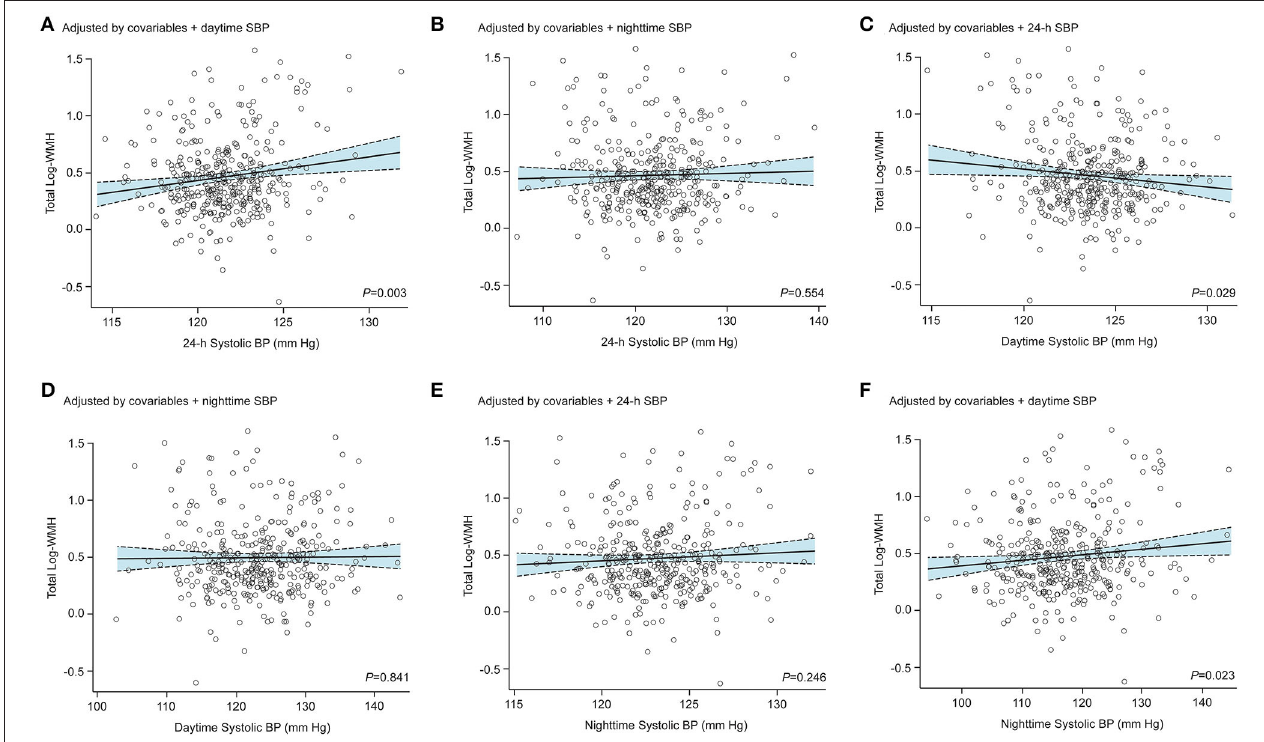
FIGURE 2 | Association between total log-transformed white matter hyperintensities and standardized ambulatory systolic blood pressure measurements. The ambulatory blood pressure (BP) measurements were all standardized by sex, age, education, cephalic circumference, body mass index (BMI), diabetes mellitus, high-density serum cholesterol, use of antihypertensive treatment, glomerular filtration rate, and history of cardiovascular diseases. The 24-h systolic BP was additionally adjusted for daytime (A) and nighttime (B) systolic BP levels. The daytime systolic BP was additionally adjusted for 24-h (C) and nighttime (D) systolic BP levels. Finally, the nighttime systolic BP was additionally adjusted for 24-h (E) and daytime (F) systolic BP levels.